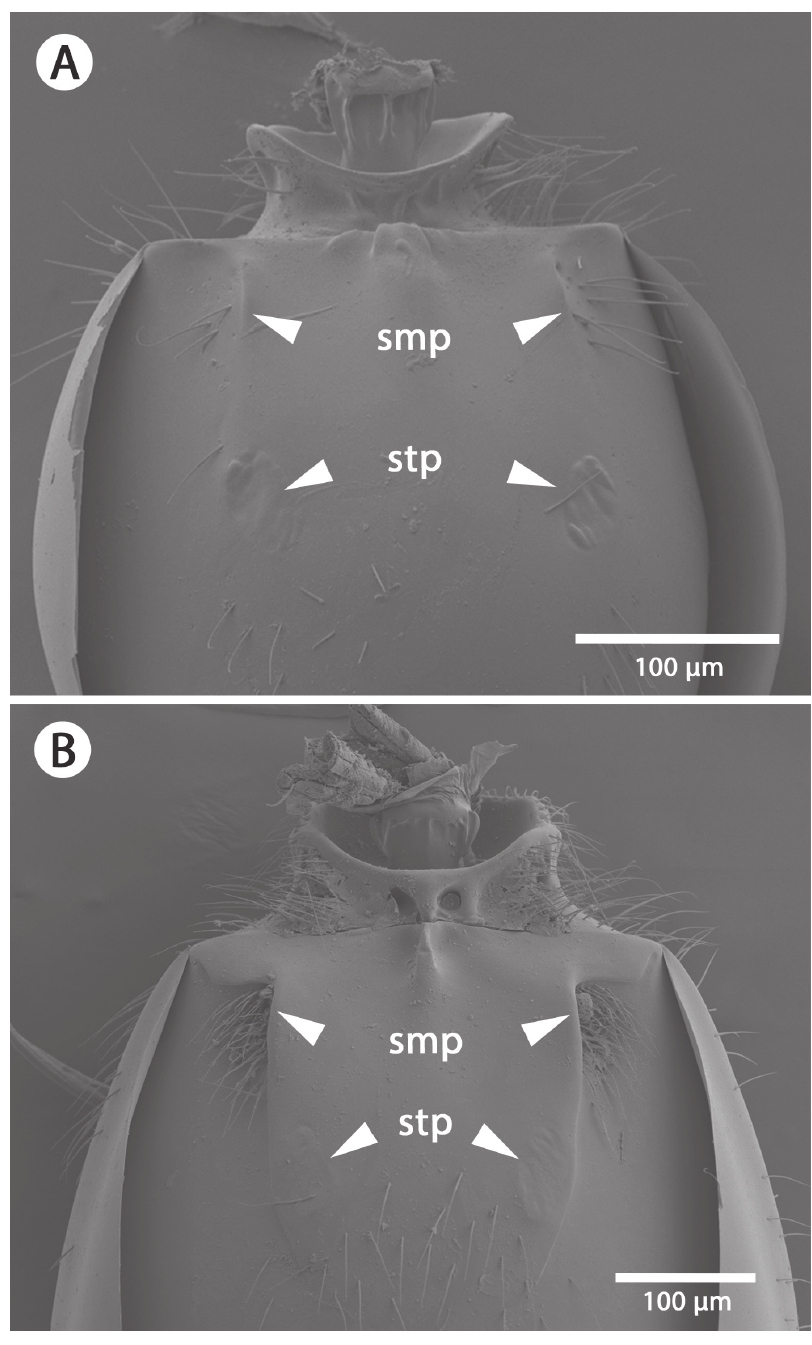
Figure 4. SEM image of the synsternal translucent patch and synsternal setiferous patch in a male ( A ) and female ( B ) Lagynodes sp. (Hymenoptera: Megaspilidae) Specimens from lot IM 930. Abbreviations: smp = synsternal setiferous patch; stp = synsternal translucent